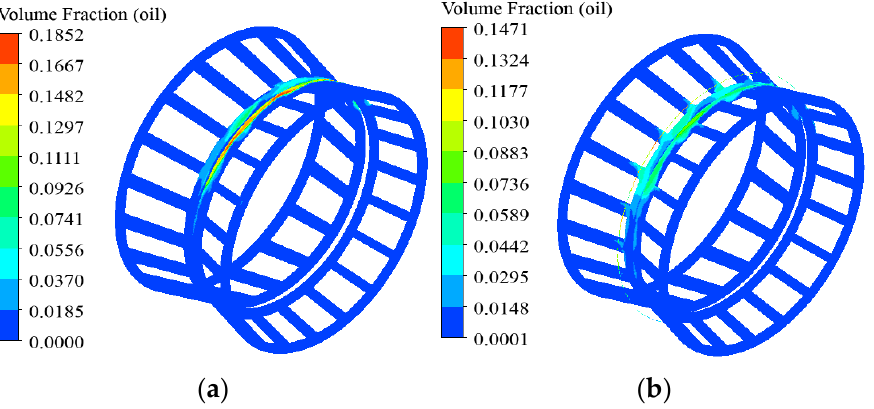
Figure 14. Lubricating oil distribution contours on cage walls. ( a ) Outer ring rib structure; ( b ) Inner ring rib structure.